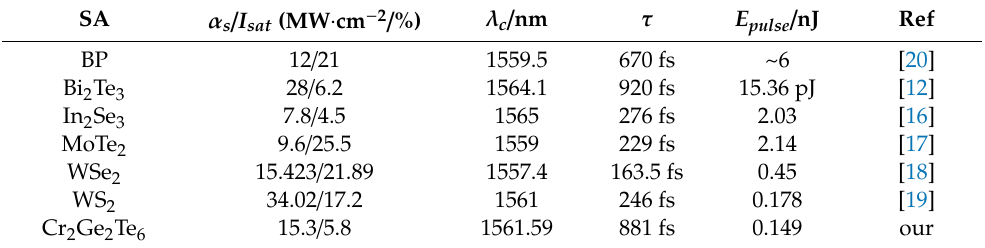
Table 1. Comparison of mode-locked Er-doped fiber lasers based on different 2D saturable absorbers (SAs).